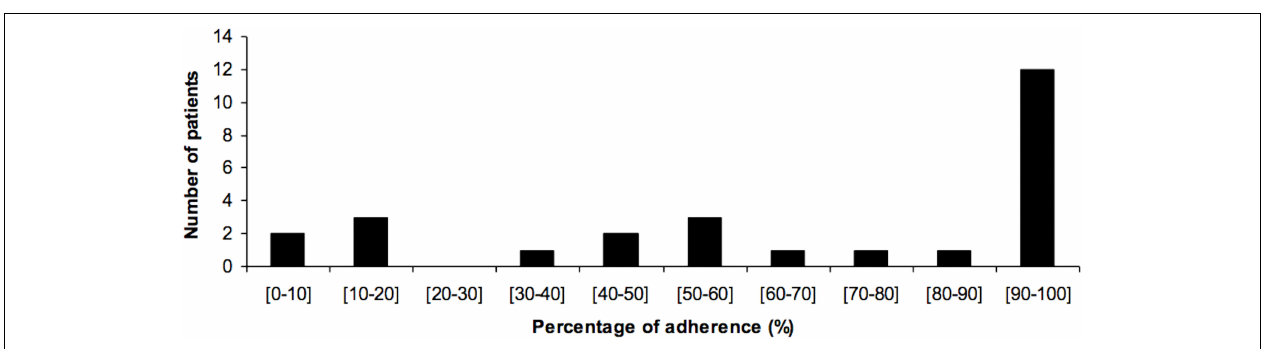
FIGURE 2 |Adherence to treatment as recorded by the DoPill ® .